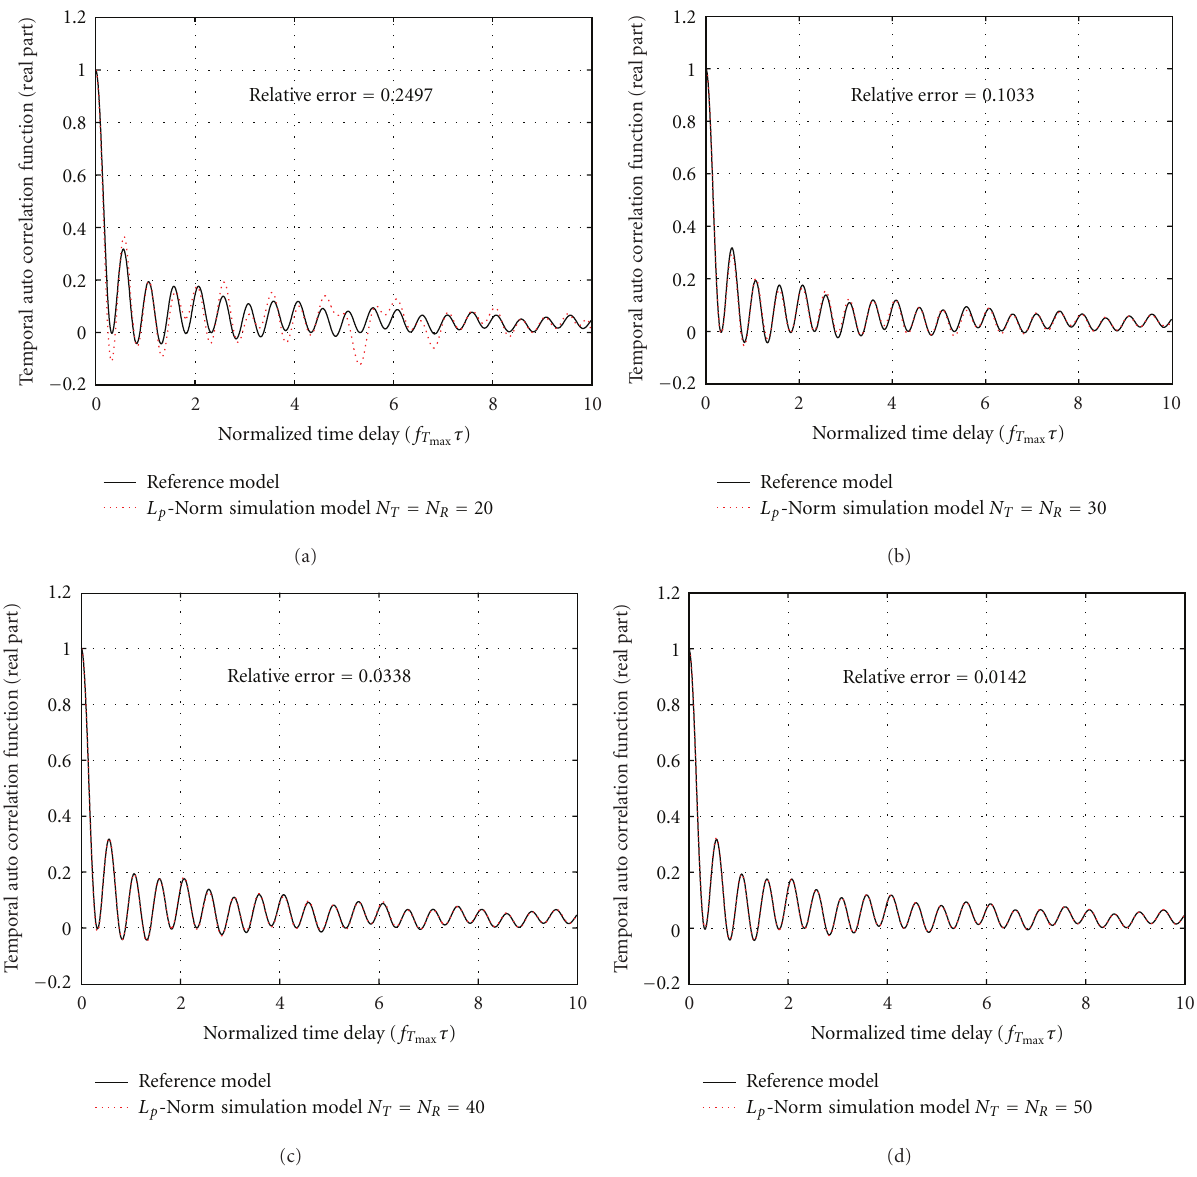
Figure 4: The normalized temporal ACF of the nonisotropic reference model and the L p -Norm simulation model for N T = N R = 20, 30, 40, 50 (real